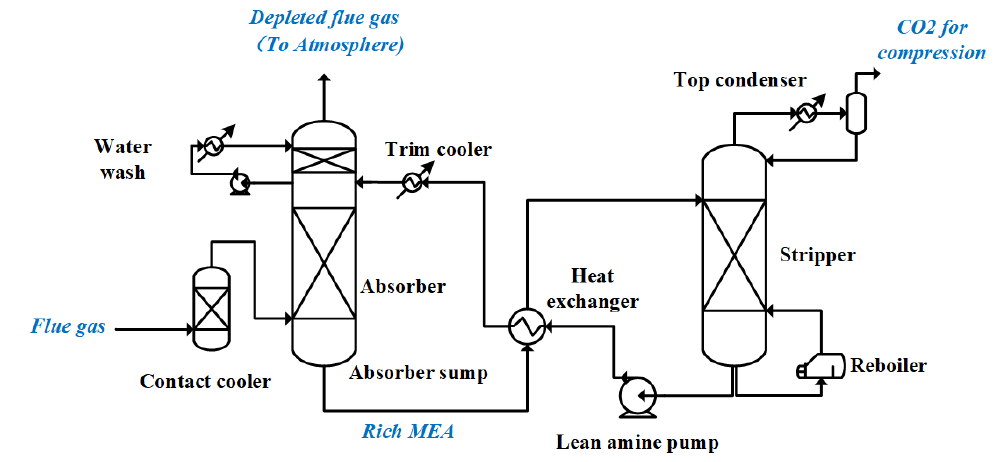
Figure 2. Schematic of chemical absorption process representing postcombustion CO 2 capture (PCC).